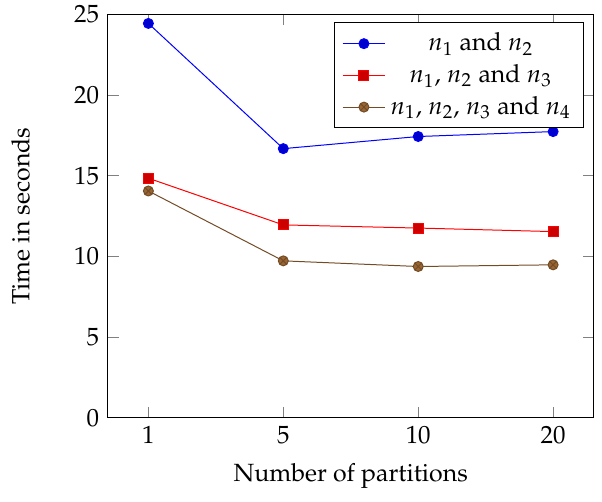
Figure 2. Distributing data by nodes.